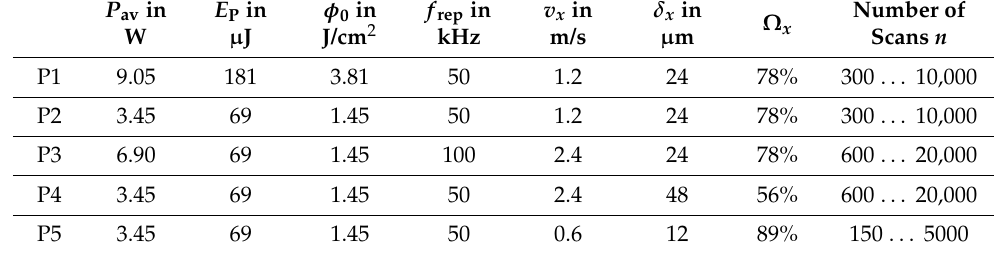
Table 1. Sets of parameters as used for micromachining of grooves with different depths and widths.